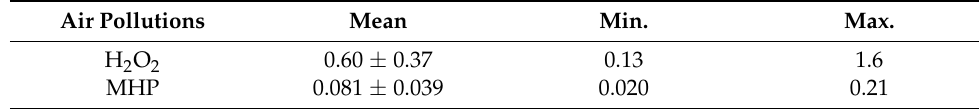
Table 7. Concentrations of H 2 O 2 and MHP in Beijing, September 2016 (ppb).